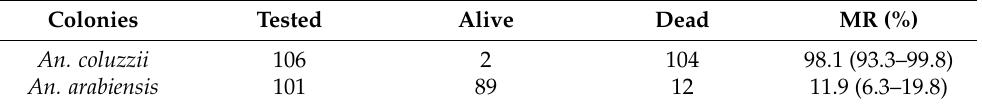
Table 1. Mortality rates of the laboratory and wild colonies to 0.05% deltamethrin . Colonies